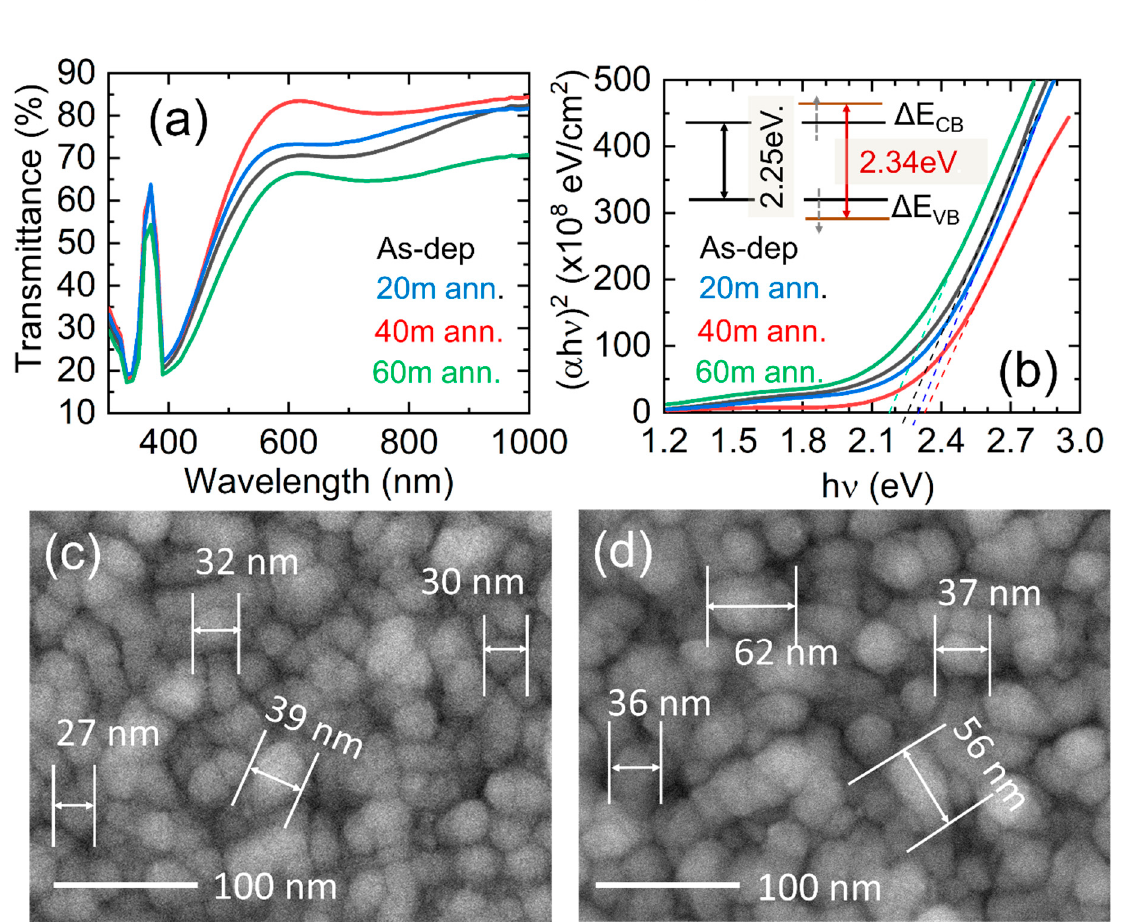
Figure 2. ( a ) Optical transmittance of the films, ( b ) bandgap evaluation curves for the Cu x O thin films annealed in an N 2 /O 2 (80:20) ambient at different time duration (insets: schematic of bandgap diagrams varied due to the thermal annealing), and ( c , d ) SEM image for 40 min annealed and 60 min annealed films.